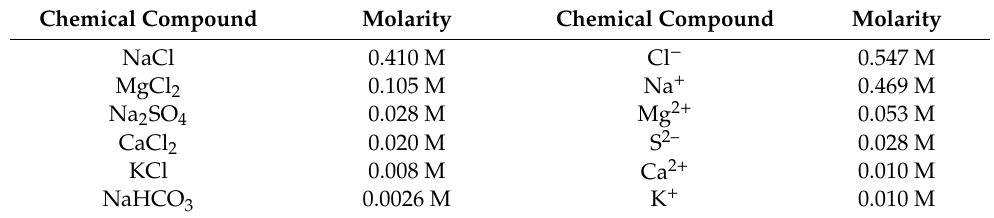
Table 2. Chemical composition (molarity) of artificial seawater (left) and natural seawater (right). Chemical